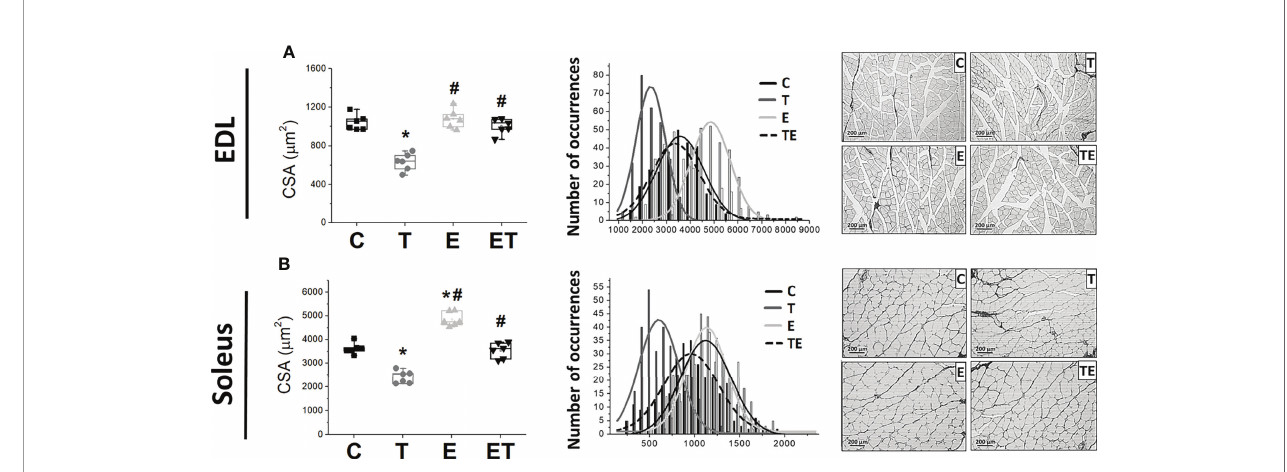
FIGURE 2 | Resistance exercise attenuates tumor-induced muscle loss. Scatter plot of the median cross-sectional area (left) and cross-sectional area distribution by occurrence number (right) of (A) soleus muscle (n = 6) and (B) EDL muscles (n = 6); representative images of cross-sectional area of soleus muscle (C) in groups control, tumor bearing, exercised and tumor-bearing exercised. * p < .05 , compared with control group; # p < .05 , compared with Tumor-bearing group (by Kruskal- Wallis test followed by Dunn ’ s post-hoc) . C, control group; CSA, Cross Sectional Area; E, exercised; EDL, extensor digitorum longus; T, tumor-bearing; TE, tumor- bearing exercised.